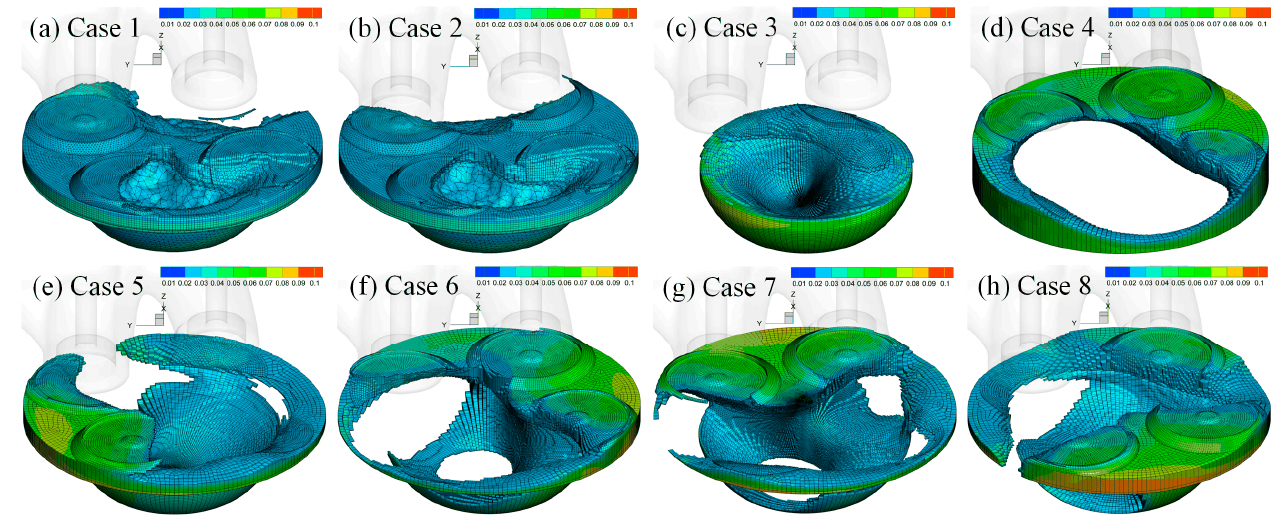
Figure 10. The in-cylinder FMF distributions of all 8 cases at the ignition time.